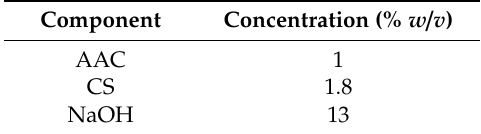
Figure 3. Diameter contour plot for CS spheres. Conditions: Needle 1, R.H. 10% ± 0.1%. Table 2. The optimal formulation for CS spheres synthesis.